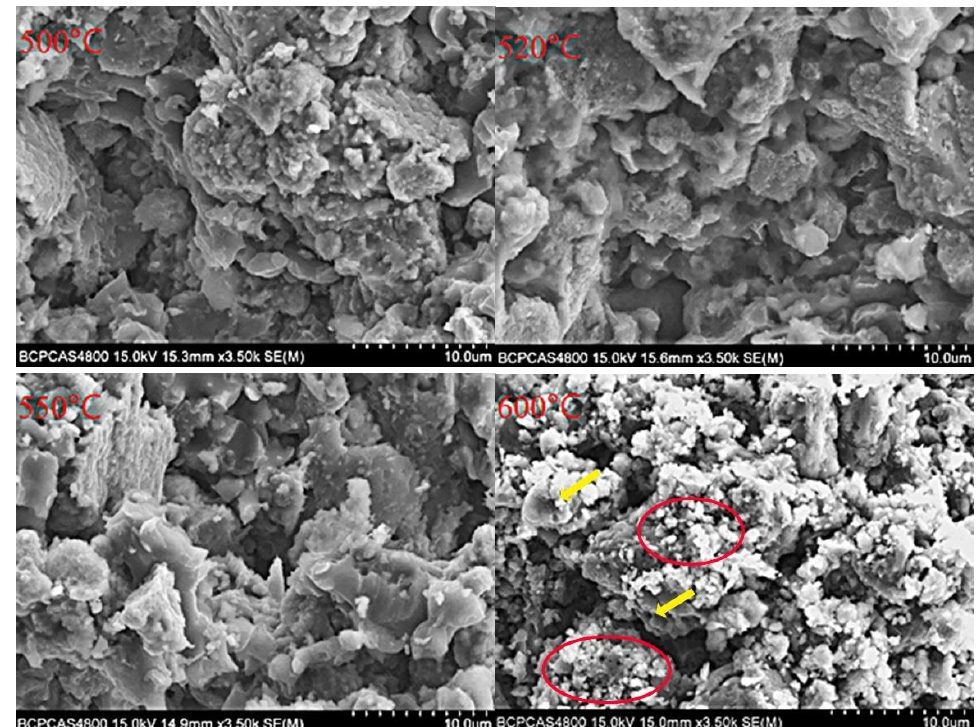
Figure 12. SEM micrographs of the fractured composites.